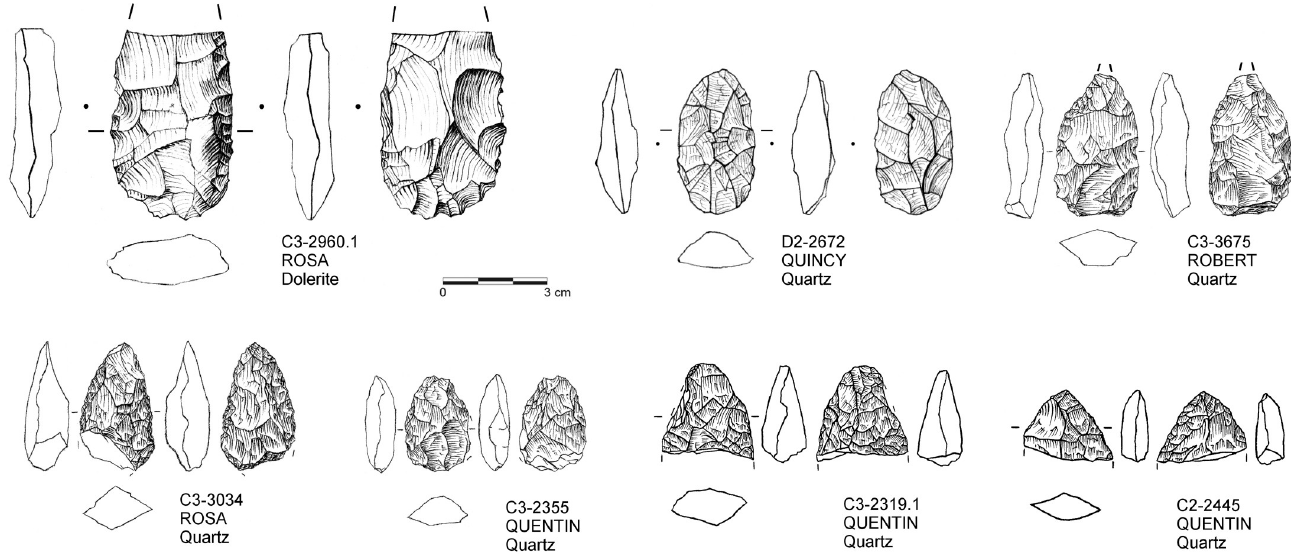
Fig 8. Drawings of bifacial pieces from Sibudu with indication of find number, raw material and layer. THE = oldest layer; QUE = youngest layer.